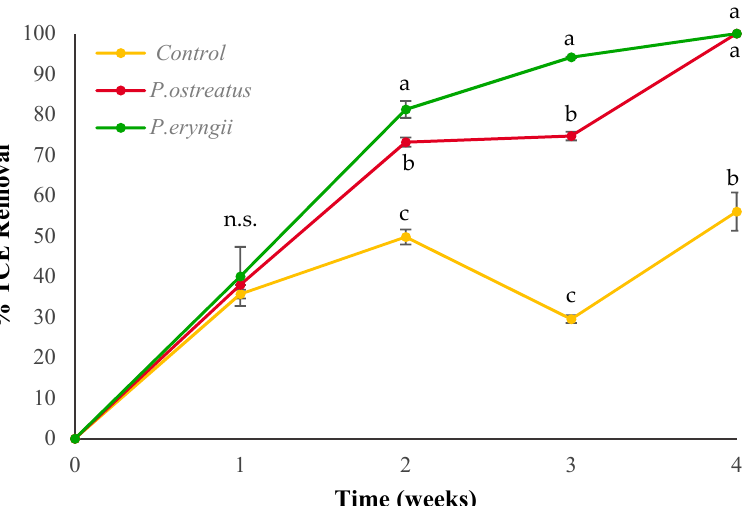
Figure 4. Percentage of TCE removal in polluted soil with TCE at 140 mg kg − 1 for the control and mycoremediation treatments ( P. ostreatus and P. eryngii ). Error bars represent the standard deviation ( n = 3). Different letters indicate significant differences among treatments at the same sampling time (Tukey post hoc test, p < 0.05). n.s.: not significant.